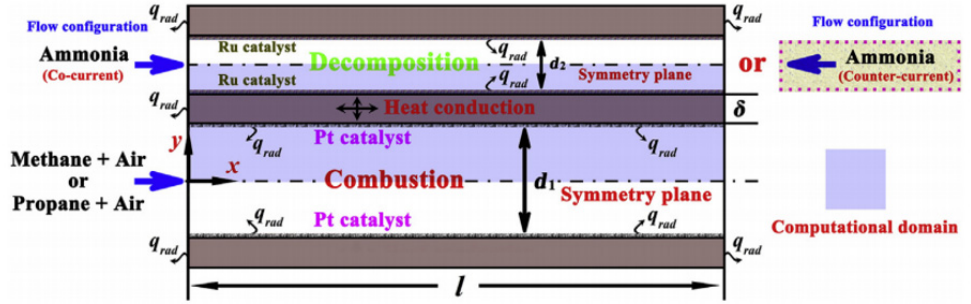
Figure 10. Schematic of a multifunctional microreactor for coupled NH 3 decomposition and combustion [37].